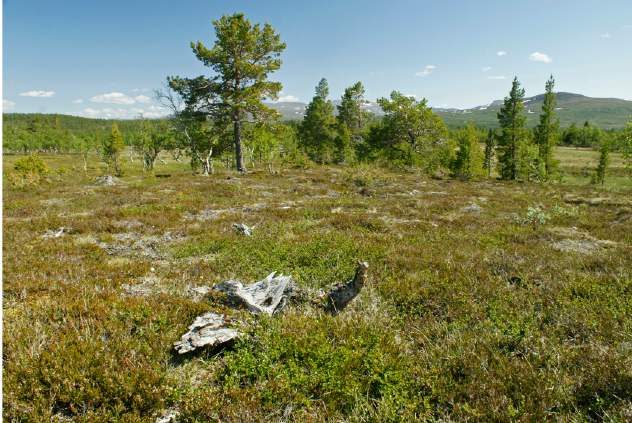
Figure 34: By 1915, this was a treeline site with only a few tiny pine trees growing in a matrix of alpine tundra (Kull- man 2005d). During the Medieval period, a dense stand pre- vailed here, as indicated by radiocarbon dated megafossils (foreground). It was gradually exterminated throughout the Little Ice Age. Reforestation during the past century has only succeeded in the least exposed part of the site.